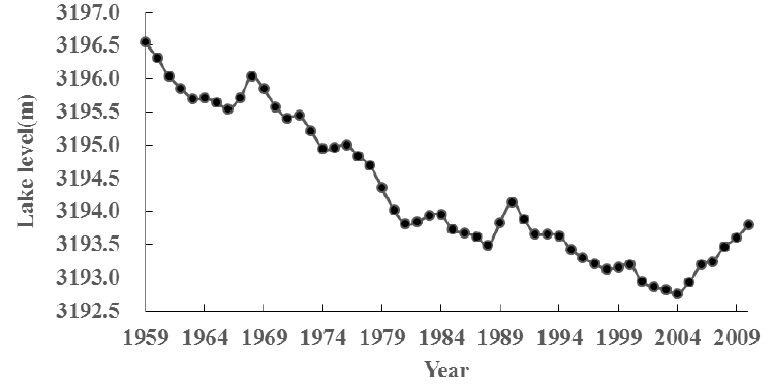
Figure 2. Variation of the water level in Qinghai Lake from 1959 to 2010.